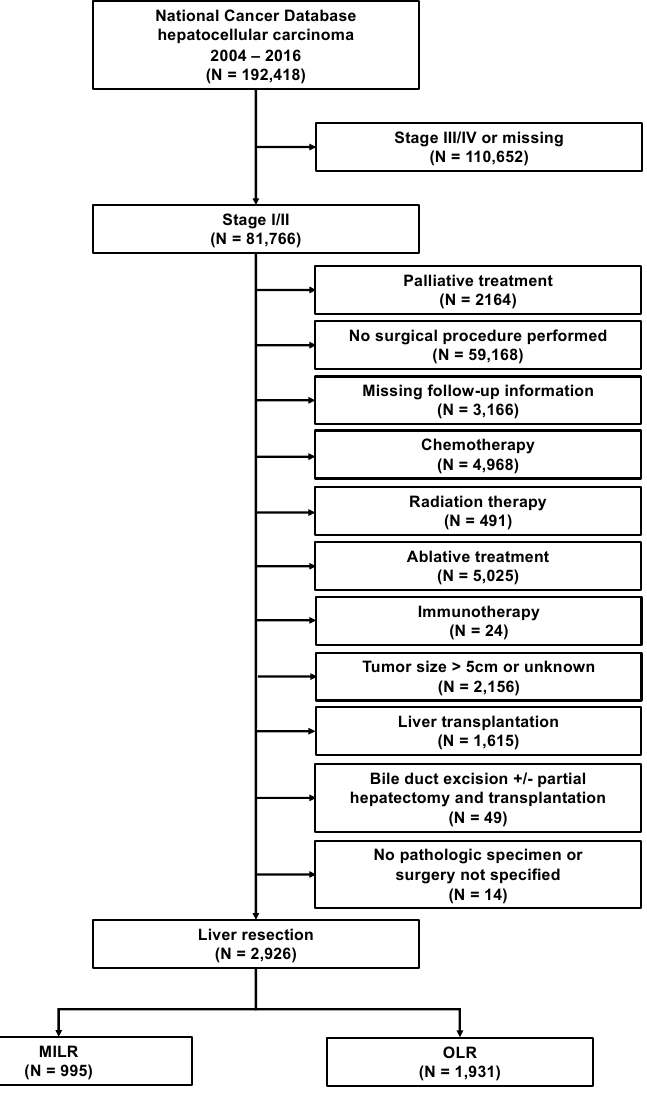
Figure 1. Flow diagram. AJCC, American Joint Committee on Cancer; MILR, minimally invasive liver resection; OLR, open liver resection.